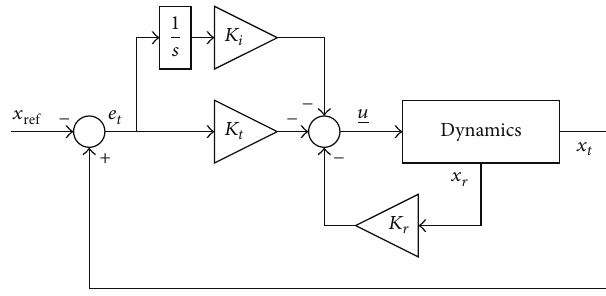
Figure 10: Structure of the LQ tracker with the